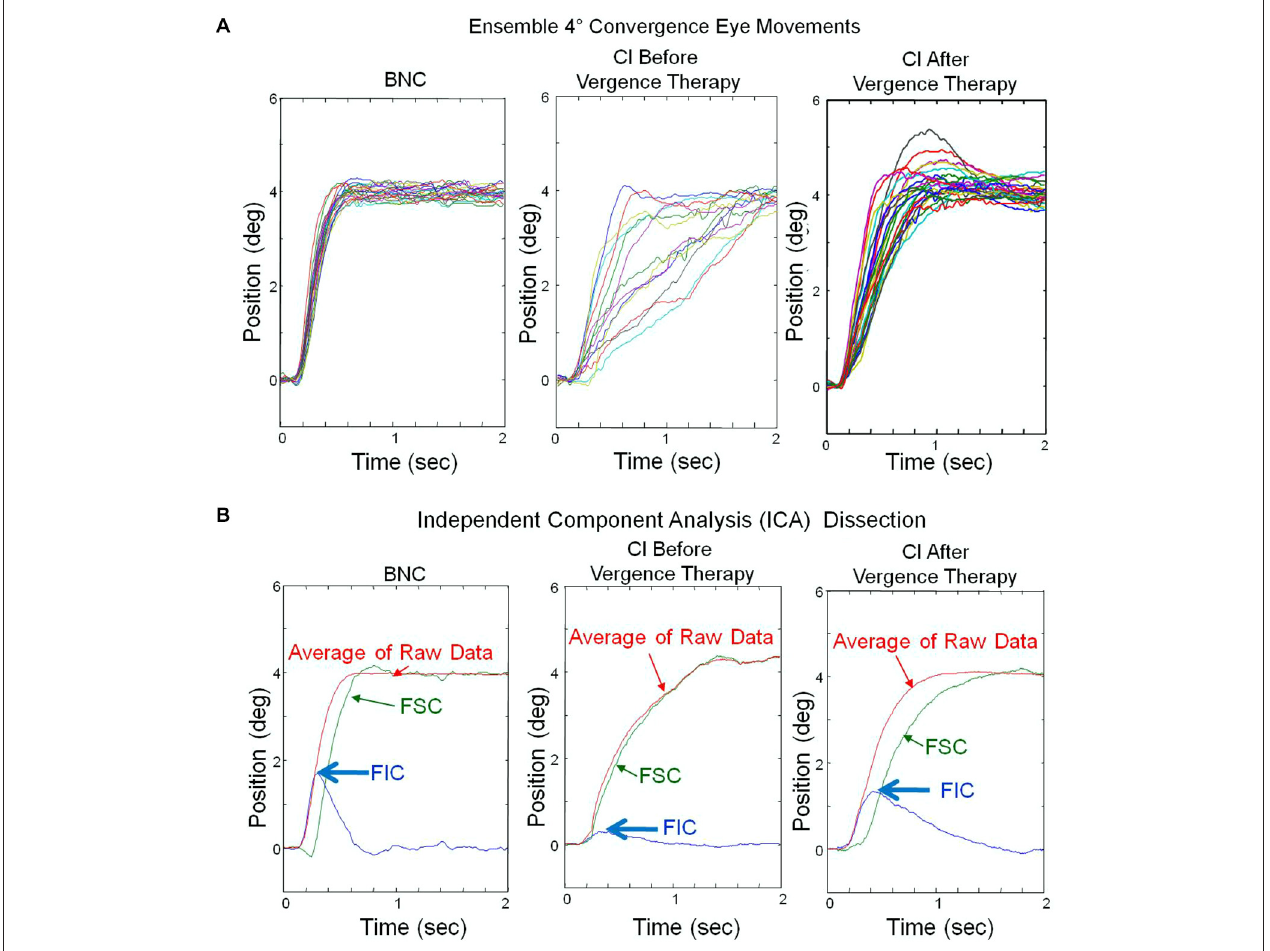
ensemble responses from plots (A) . The average of the ensemble eye movements (red), the FIC (blue) and the FSC (green) are plotted. The peak magnitude of the FIC (blue arrow) is reduced in the CI subject before vergence therapy, compared to the BNC, and increases to be more similar to the BNC after vergence